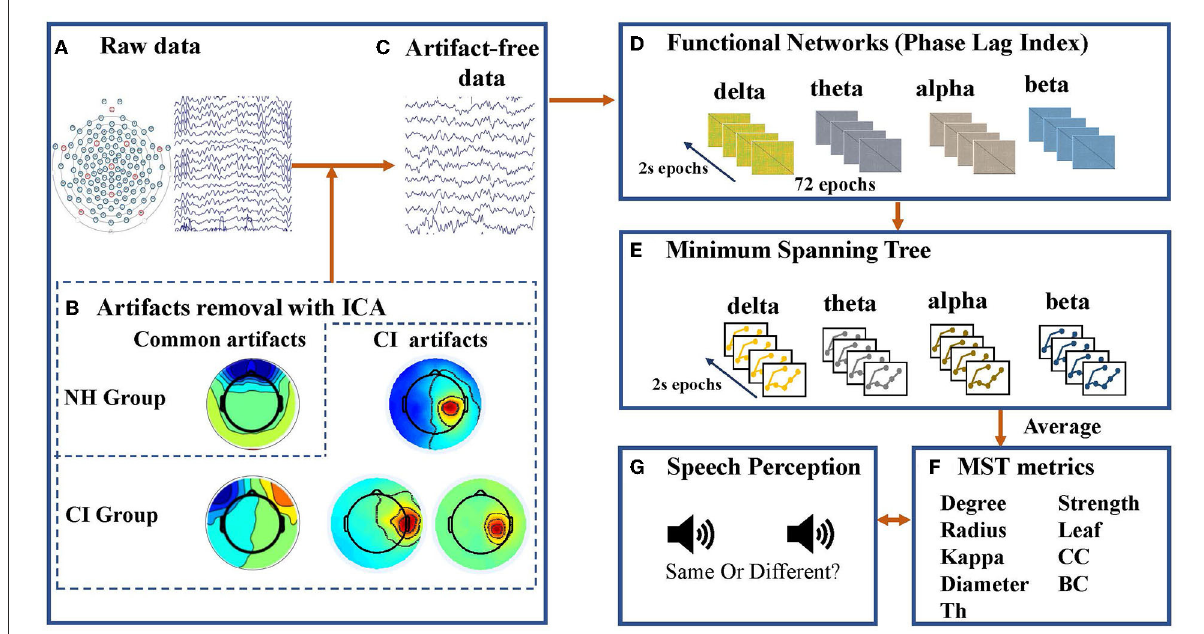
FIGURE2 Schematic overview of minimum spanning tree (MST) analysis applied to electroencephalogram (EEG) data in this study. (A) Raw EEG data was collected by an EGI 128-channel dense array EEG system with Hydrogel Geodesic Sensor Nets. (B) Independent component analysis (ICA) was used to clean the epoched data. In addition to removing artifacts common to children with normal hearing (NH) and children with cochlear implants (CI), ICA was performed repeatedly on data from the CI group to isolate and eliminate the artifacts associated with the cochlear implant (CI artifacts). If the activated scalp showed a centroid on the side of the CI, then the independent component was defined as the CI artifact and removed. (C) Seventy-two artifact-free 2-s epochs were filtered for each frequency band (delta: 0.5–4 Hz, theta: 4–8 Hz, alpha: 8–13 Hz, and beta: 13–30 Hz). (D) A resting-state functional connectivity matrix based on the phase lag index (PLI) was constructed for each frequency band and each epoch. (E) Kruskal’s algorithm was used to construct a minimum spanning tree (MST) matrix. (F) Topological characteristics of the tree can be characterized by metrics including maximum node degree (degree), leaf number (leaf), diameter, eccentricity, radius, strength, maximum betweenness centrality (BC), closeness centrality (CC), kappa, and tree hierarchy (Th). (G) Speech perception tests including tone, vowel, and consonant discrimination were complected by participants, and they were required to decide whether two consecutive sounds were the same as accurately and rapidly as possible.